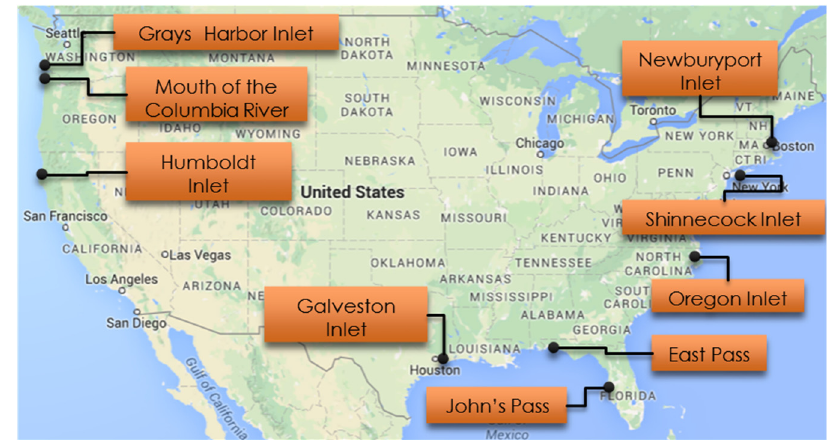
Figure 2 . Map of the nine selected inlets modeled in this study. Figure 2. Map of the nine selected inlets modeled in this study.